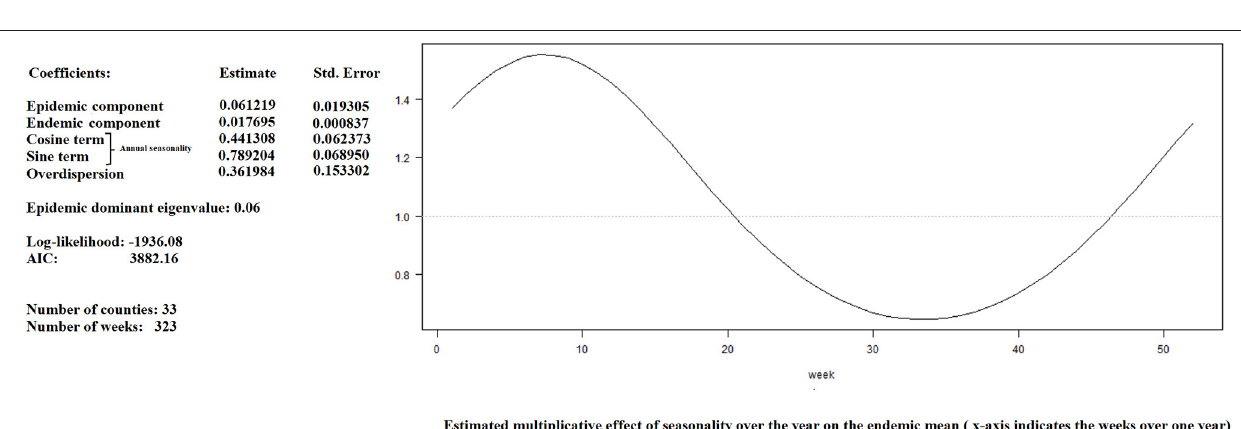
FIGURE 6 | Summary of the fitted model to data of suspected clinical events of porcine pleuropneumonia recorded by the GSP system between January, 2012 and March, 2018: coefficients and resulting multiplicative effect of seasonality on the endemic